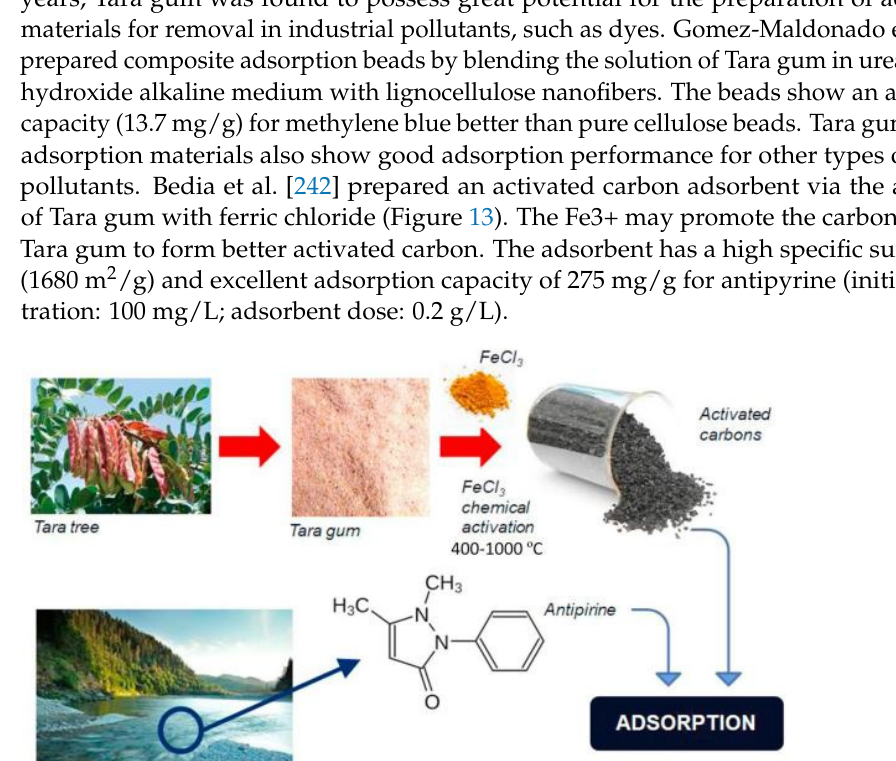
Figure 13. Preparation process of Tara gum-derived activated carbon and its application for adsorp- tion antipyrine in water [242].